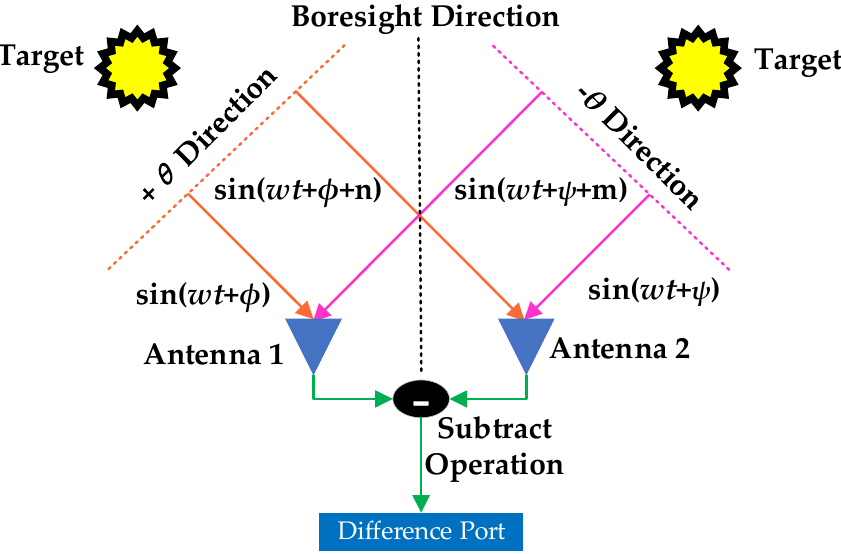
Figure 15. The difference signals for the reflected signals of two symmetrical directions. Figure 15. The di ff erence signals for the reflected signals of two symmetrical